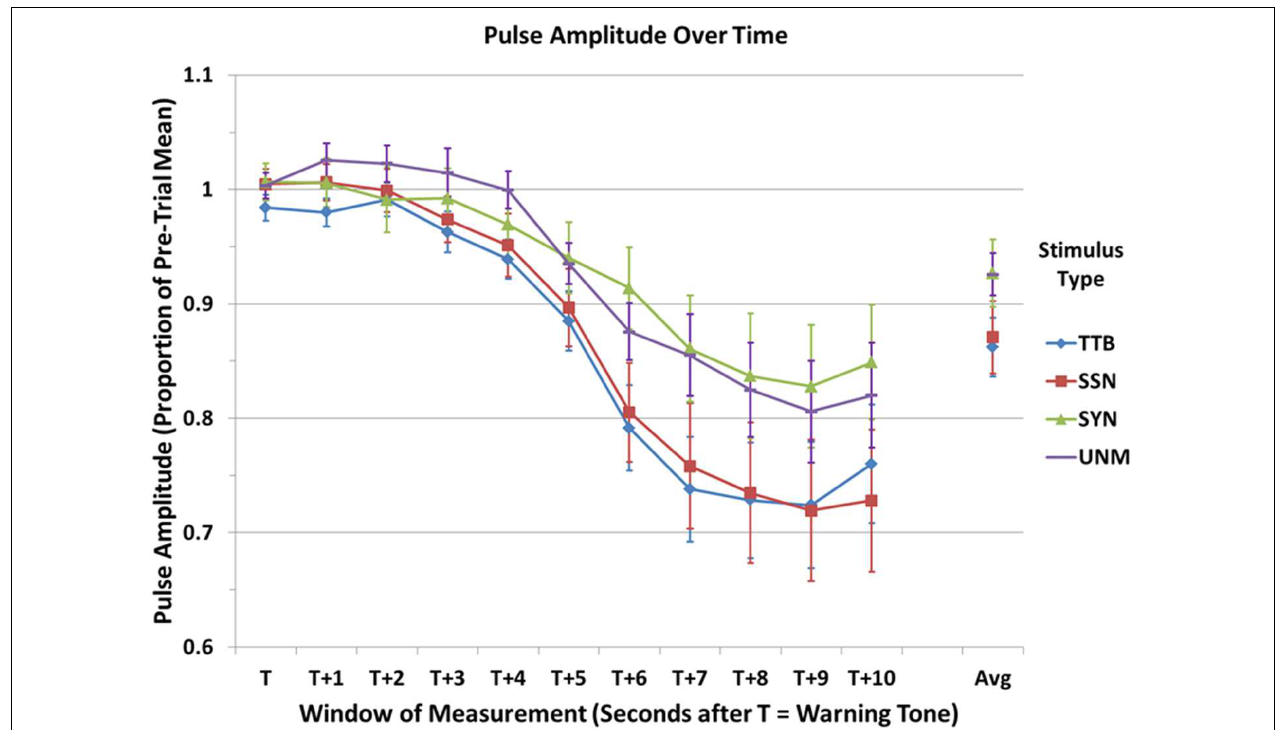
FIGURE 3 | Mean pulse amplitude (PA) at 1 s intervals over the 10 s window of analysis, expressed as a proportion of the mean PA over the 2 s immediately preceding the onset of the trial. TTB, natural speech masked with two-talker babble; SSN, natural speech masked with speech-shaped noise; SYN, unmasked computer synthesized speech; UNM, unmasked natural speech. Error bars indicate standard error of the mean. See text for statistical